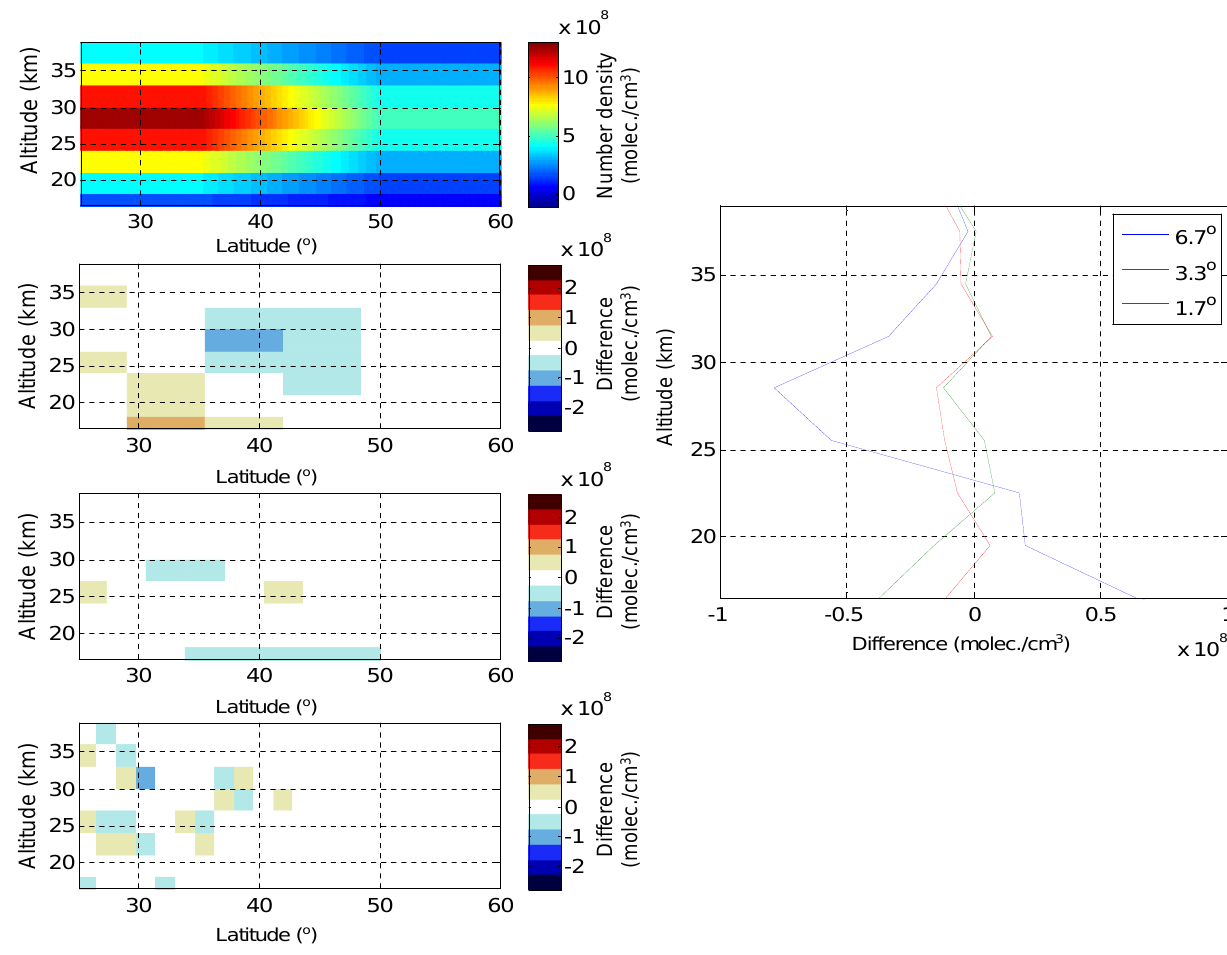
Fig. 14. 2-D retrieval for different distances between consecutive scanning sequences. On the left: the NO 2 field of the simulation (top) and the differences between the retrieved number density and the true values with the distance of 6.7 ◦ (second plot), 3.3 ◦ (third plot) and 1.7 ◦ (bottom plot). On the right: mean differences are plotted for the southern part of the gradient (i.e. where the measurement is sensitive only to the areas of the gradient) for the three distances.